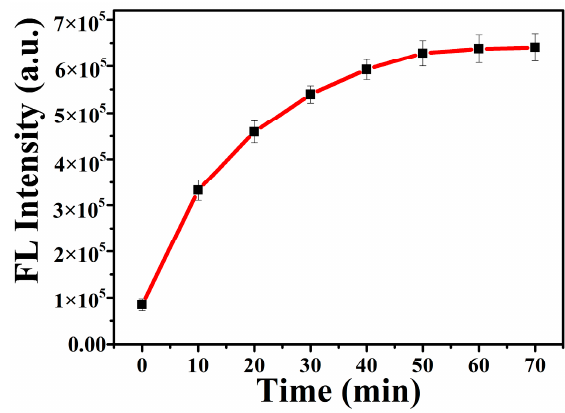
Figure 3. Fluorescence intensity of TAM-PEP (R8) in GO solution by addition of 5 μ M Bcl-xL as a function of incubation time. Excitation: 540 nm.